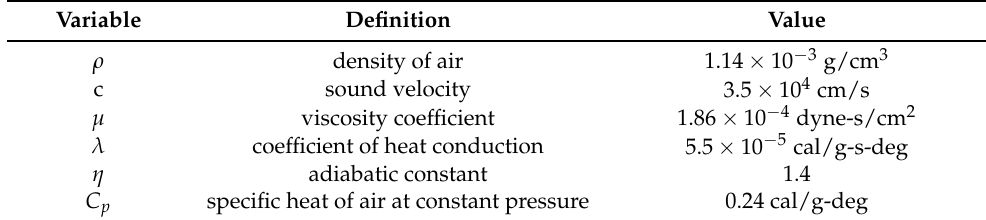
Table 2. Values for physical parameters inside the human vocal tract.